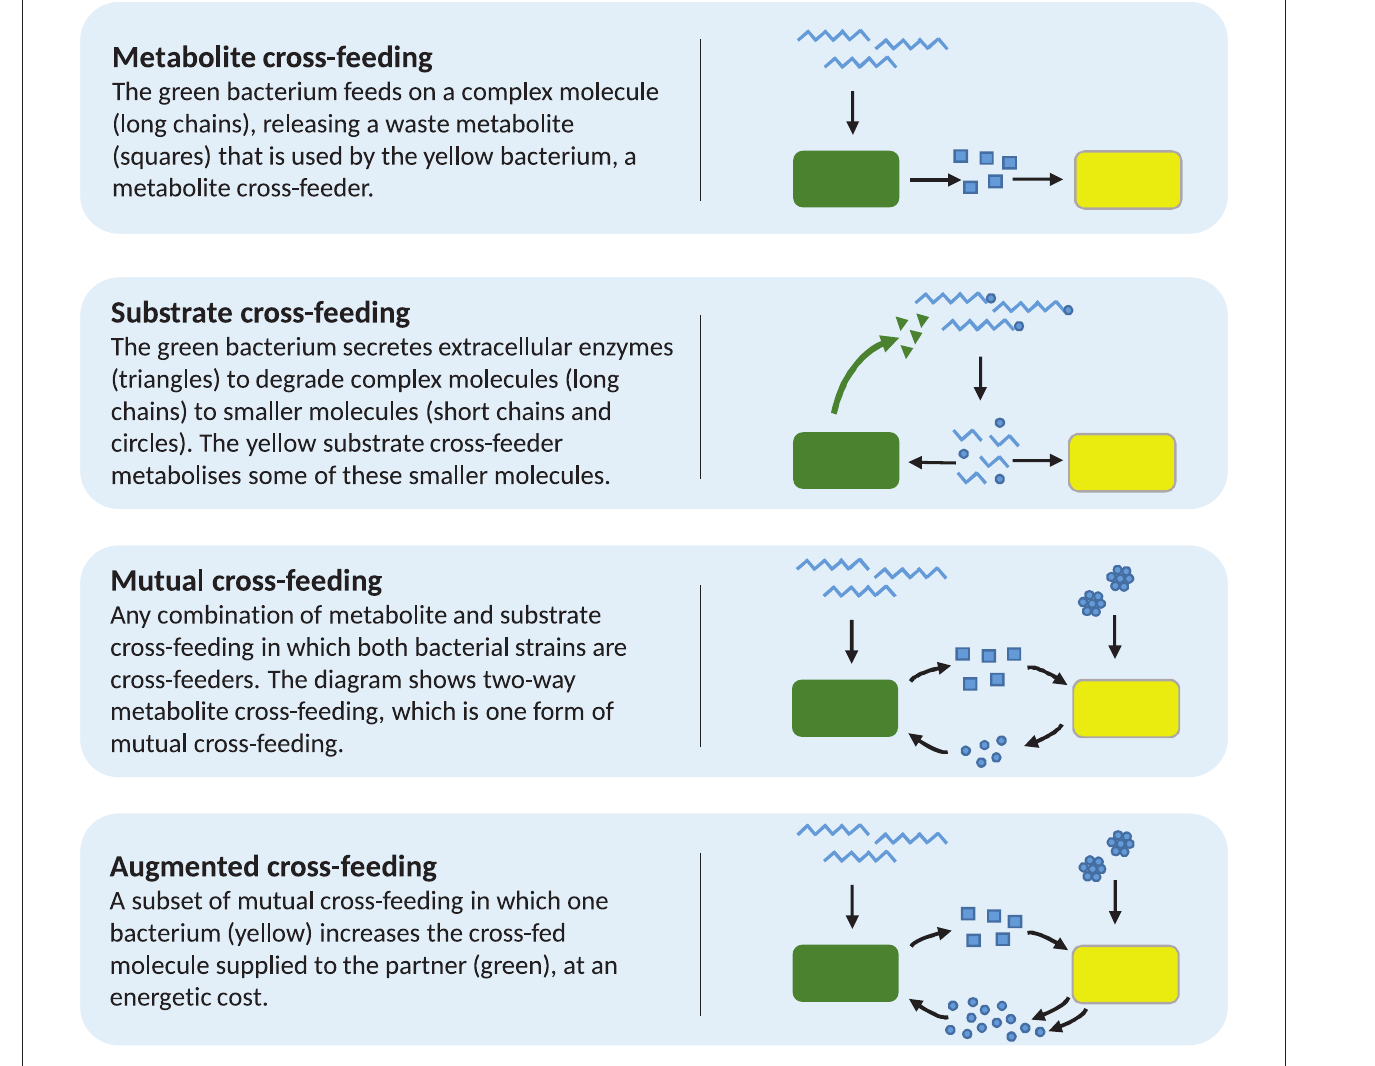
FIGURE 1 | Diagrammatic examples of each of the four forms of cross-feeding discussed in the text. Note that the example for augmented cross-feeding is identical to that of mutual cross-feeding, but for the increased metabolite production by the yellow bacterium. This is reflective of the fact that augmented cross-feeding is mutual cross-feeding with the condition that one or both strains involved must increase the supply of metabolite to their partner, at some energetic cost.